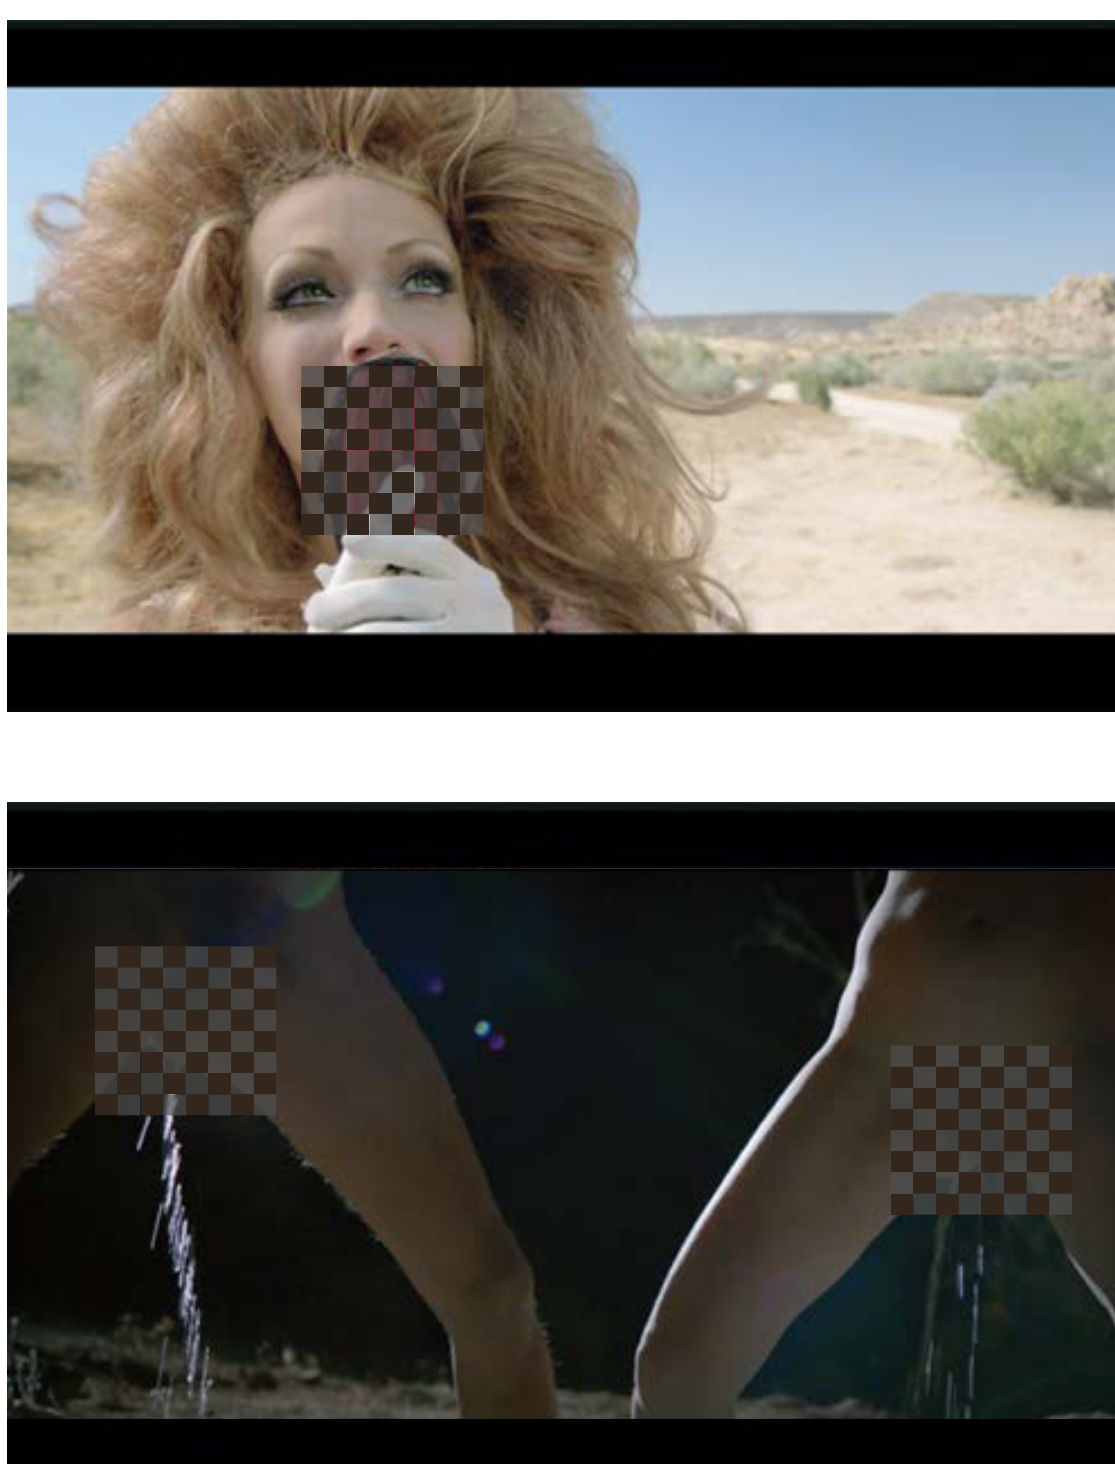
| 43Tanja Godlewsky .Female Musicians’ Visual Gender Staging in Music